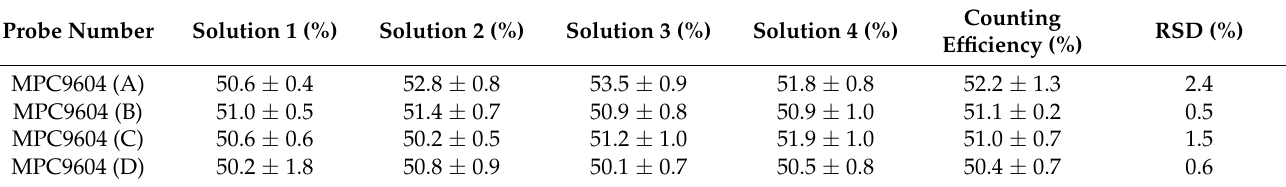
Table 1. Parallel results of counting efficiency.